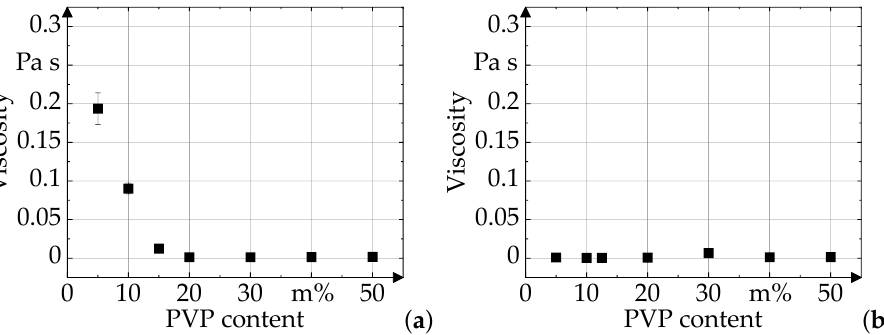
Figure 2. Viscosity as a function of PVP content for (a) an aqueous dispersion containing 10 m% graphite nanoparticles (see Table A2) and (b) a PVP solution without nanoparticles (see Table A3)